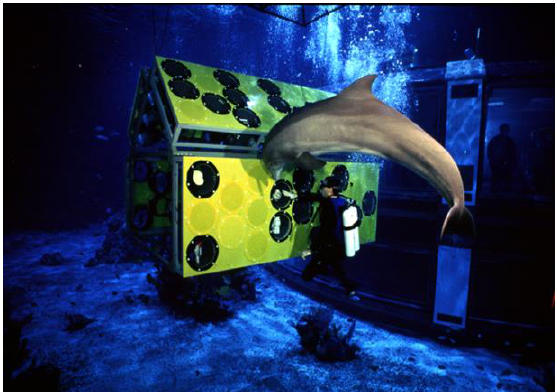
Figure 4. Diver working with dolphin at EPCOT Center’s underwater keyboard in Orlando Florida. Picture used with permission – Walt Disney World Corporation.